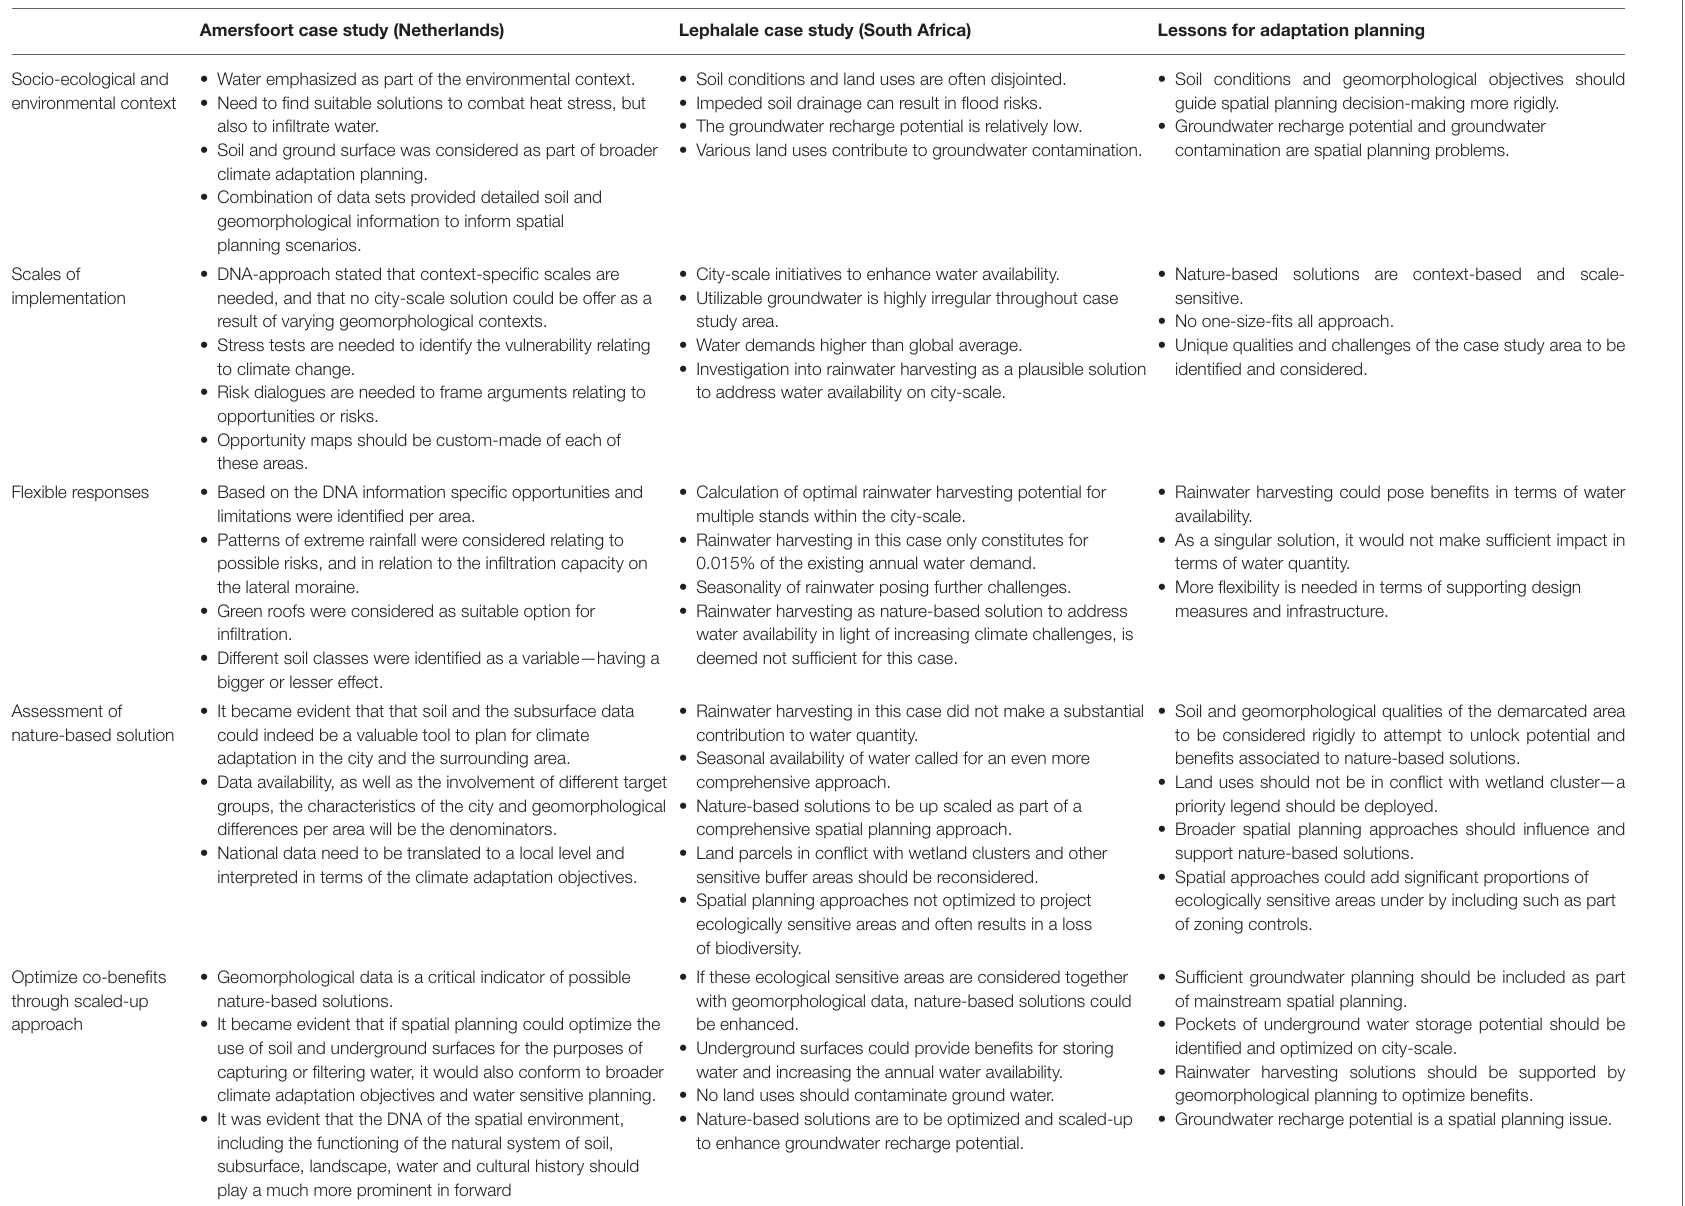
TABLE 1 | Analysis of two case studies to inform climate adaptation